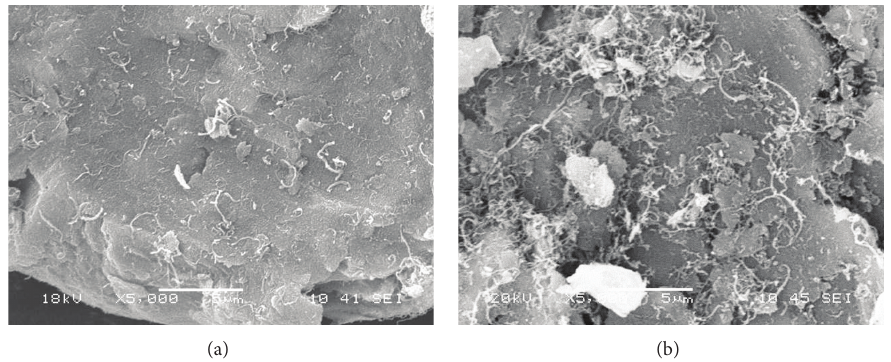
Figure 3: SEM micrographs of Al6061 composite powders containing (a) 1wt.% and (b) 2 wt.% CNTs.